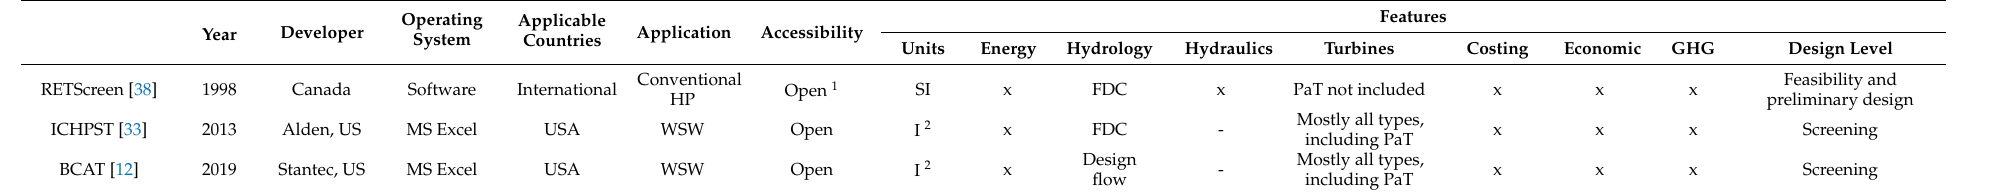
Table 7. Review of small hydropower assessment software intended for the assessment of in-conduit hydropower at individual